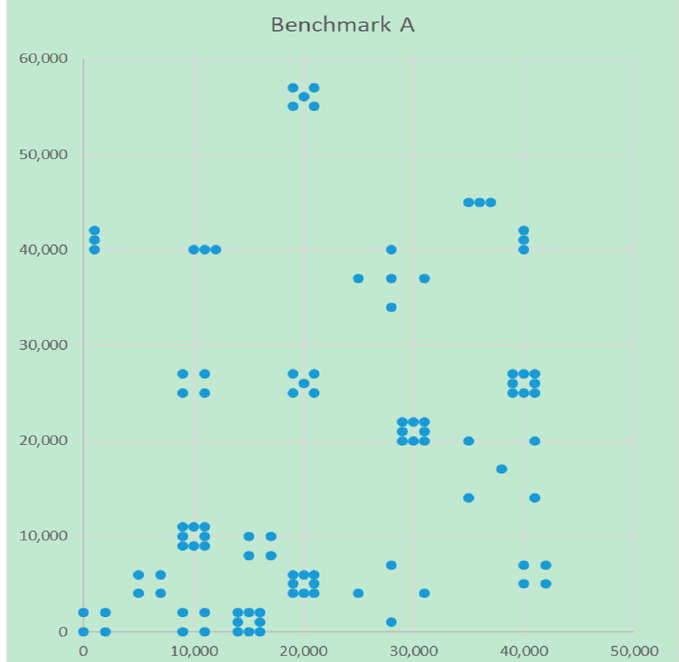
Figure 1. Benchmark instance A. Benchmark B is a combination of twenty randomly generated groups of five points, their position in the area is designed so that there is no mutual influence (Figure 2). The